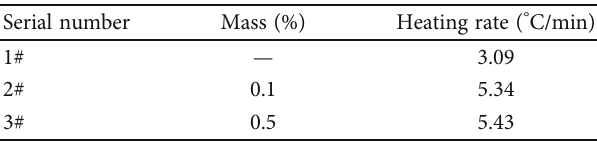
Table 4: Experimental heating rate under di ff erent catalyst mass concentration.